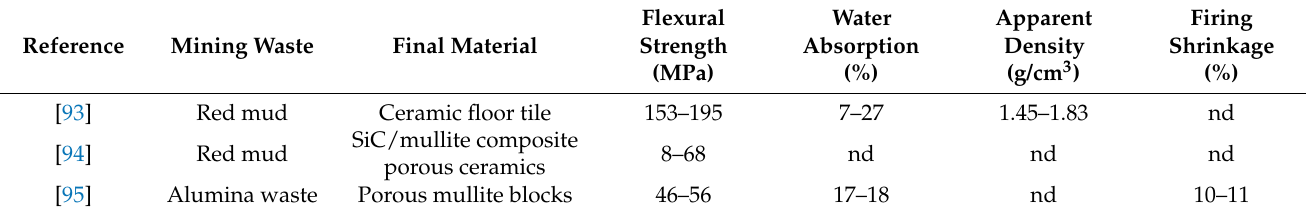
Table 6. Technological properties of mullite-based materials developed from waste generated in the Bayer process.